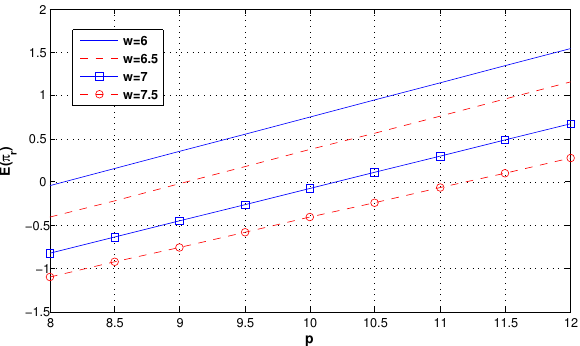
Figure 4. The expected profit of the retailer under different wholesale prices.